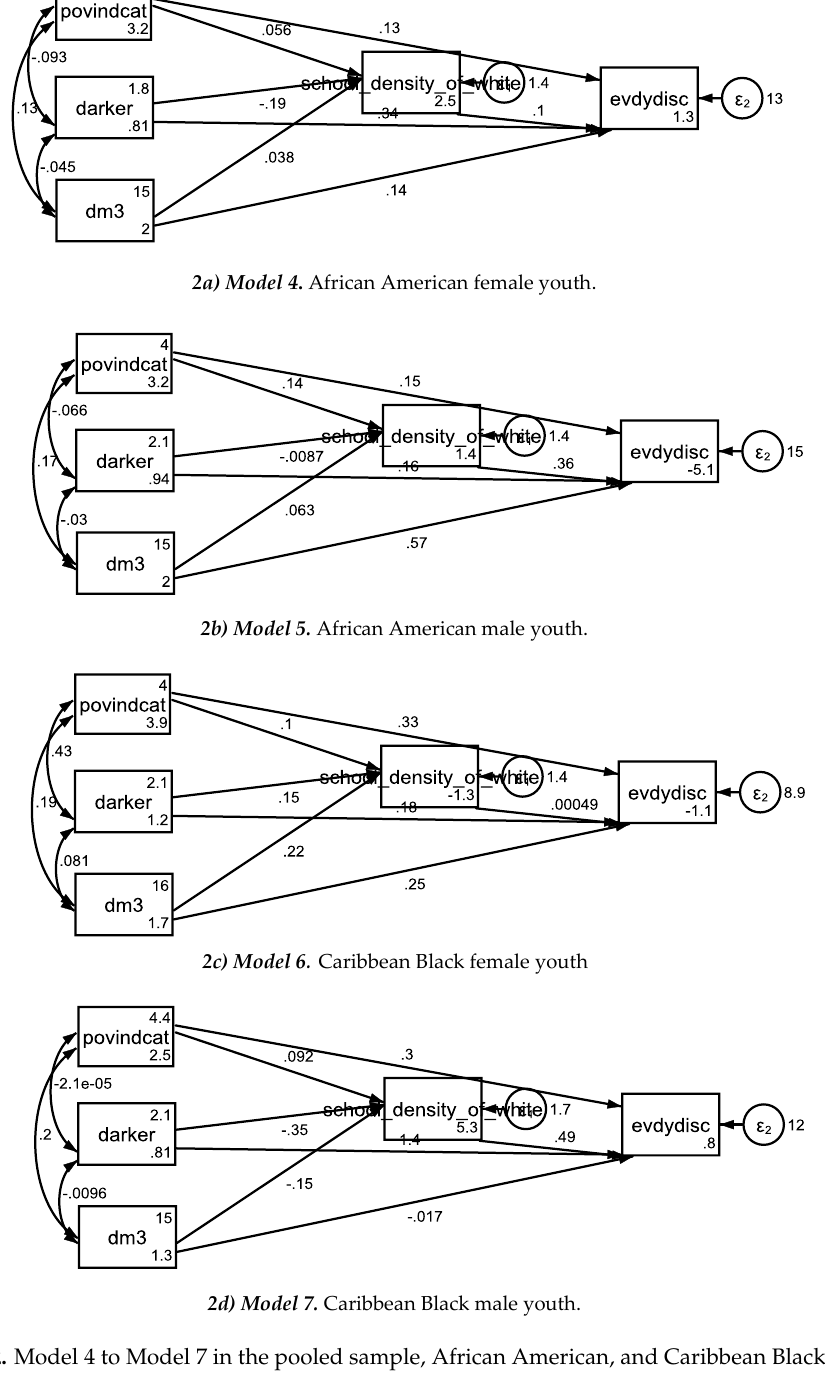
Figure 2. Model 4 to Model 7 in the pooled sample, African American, and Caribbean Black youth.